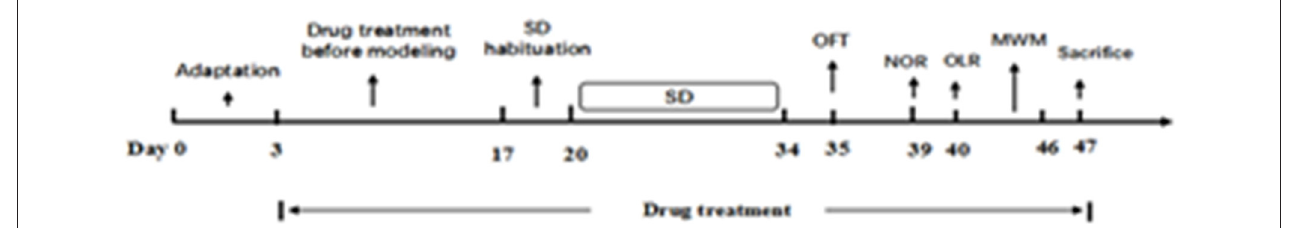
FIGURE 2 | The experimental